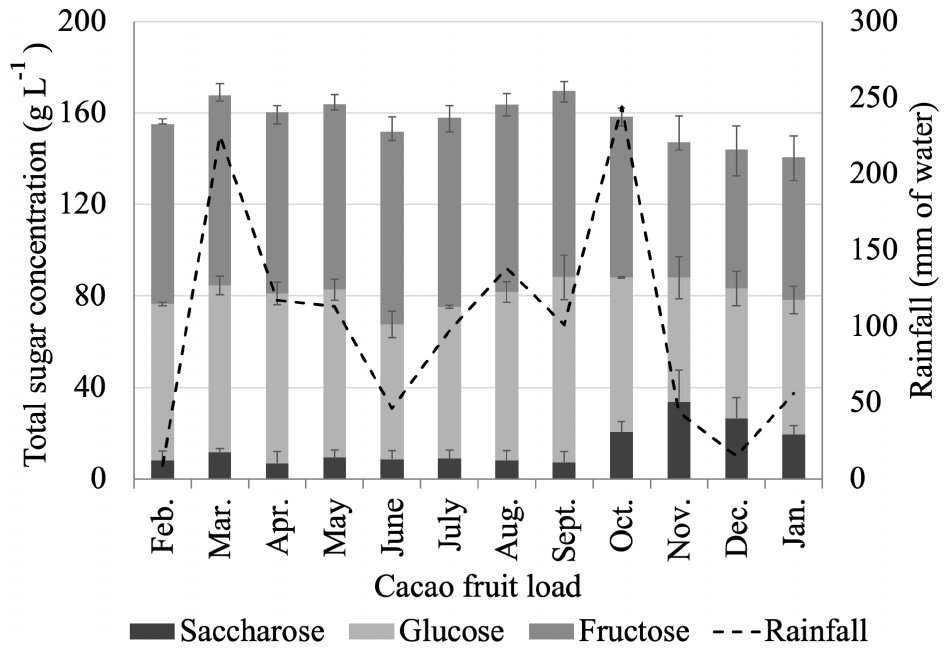
Figure 10. Seasonal variations in CME sugar content from Colombian CCN51 cacao